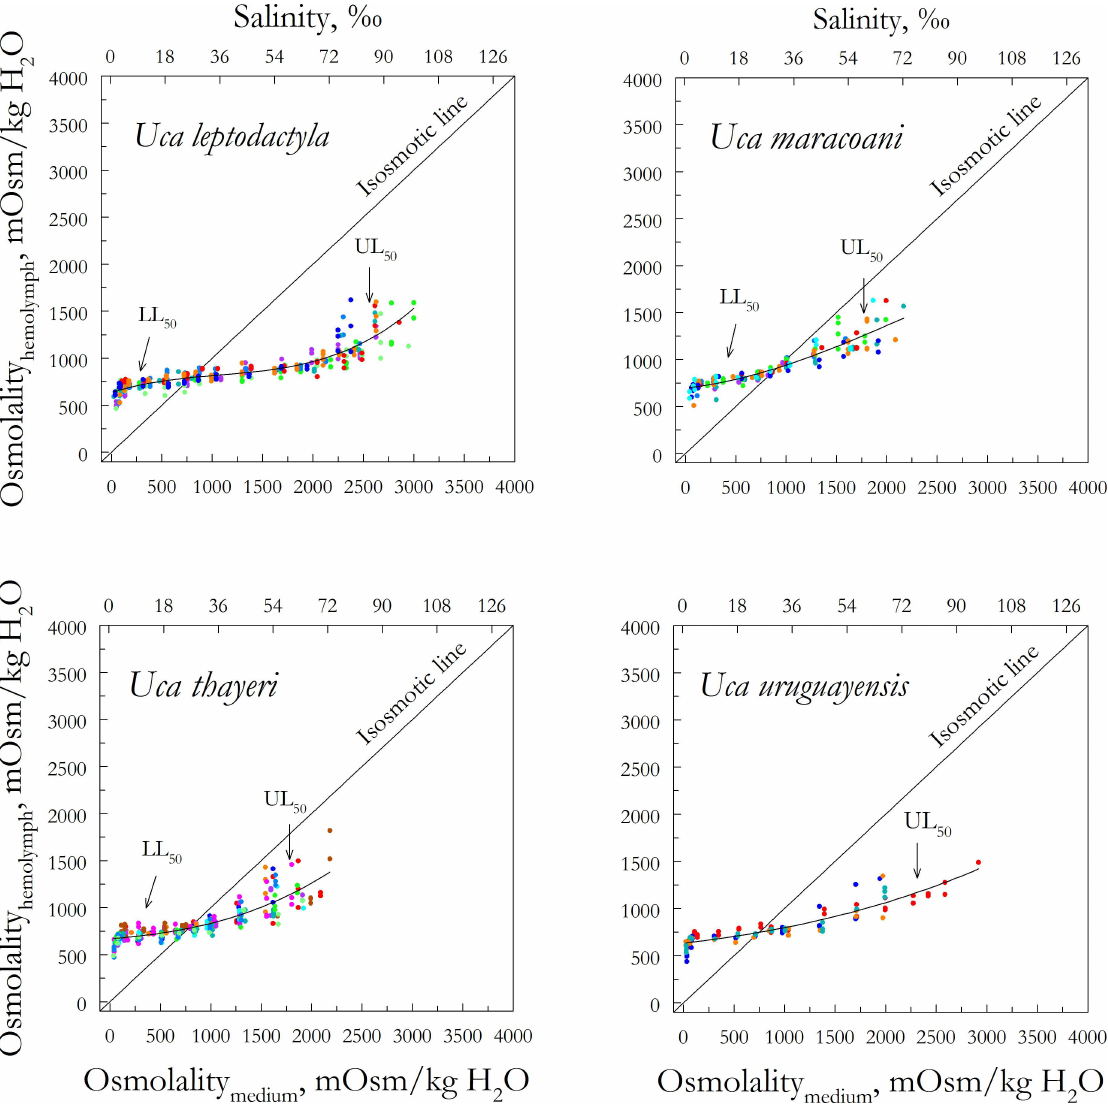
Fig 2. Hemolymph osmoregulatory capability in four Uca species. Species are color-coded by populationorderedon habitat salinity, after 5-days direct transfer from collectingsite water to each different salinity. Populations of each specieswere collected from dilute (blue) to concentrated (red) media. Data (in mOsm/kg H 2 O) represent singlemeasurements from singleindividualsin each population (12 (cid:20) N (cid:20) 57) and are adjusted to a third degreepolynomial equation (0.75 (cid:20) R 2 (cid:20) 0.85). 1 ‰ S = 30 mOsm/kg H 2